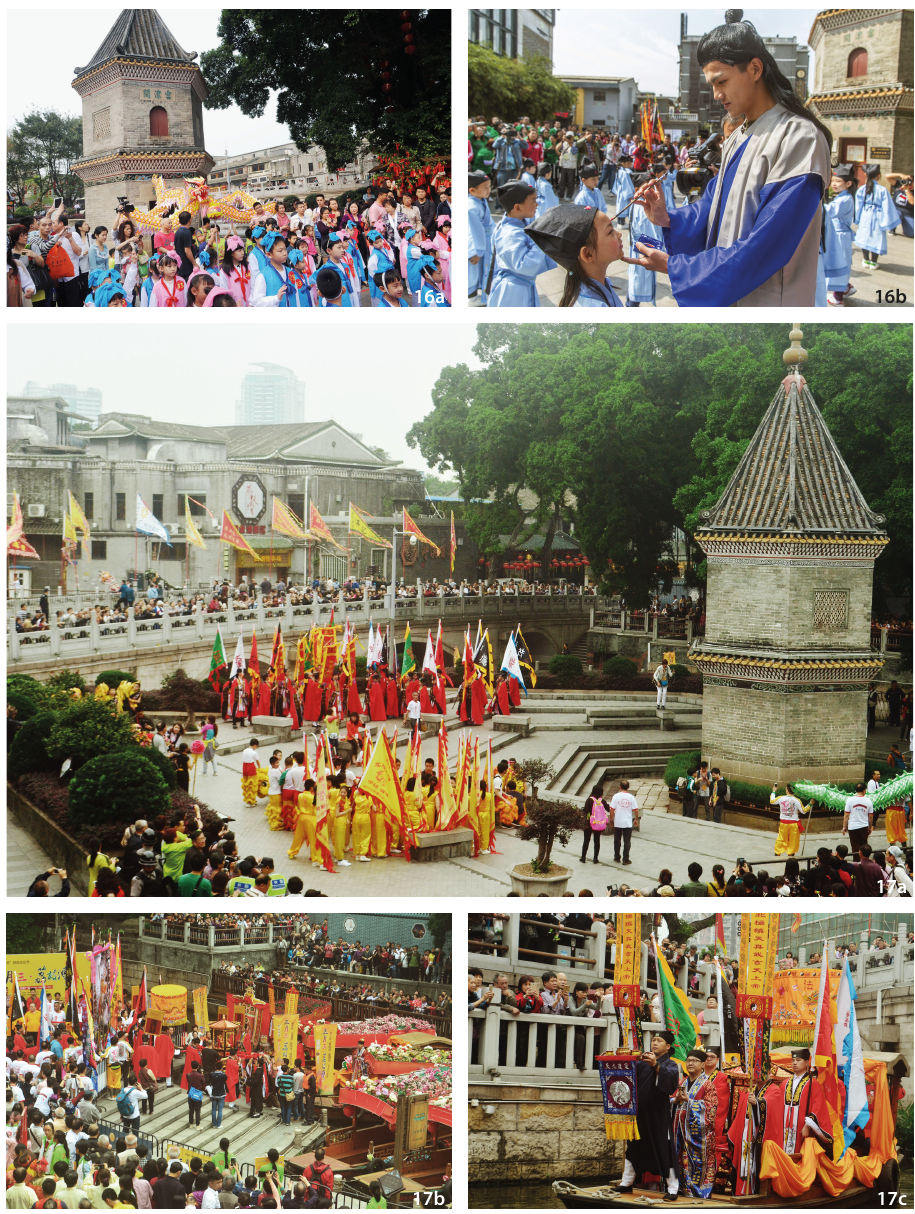
Figure 16 First Writing ceremony in 2015 (a) and 2018 (b) (Source: with the authorisation of VCG, shot by Xiao Xiong [a] and Tan Qingju [b]). Figure 17 The overwater parade on March 30, 2017, to celebrate the birth of North Deity (Source: Ke